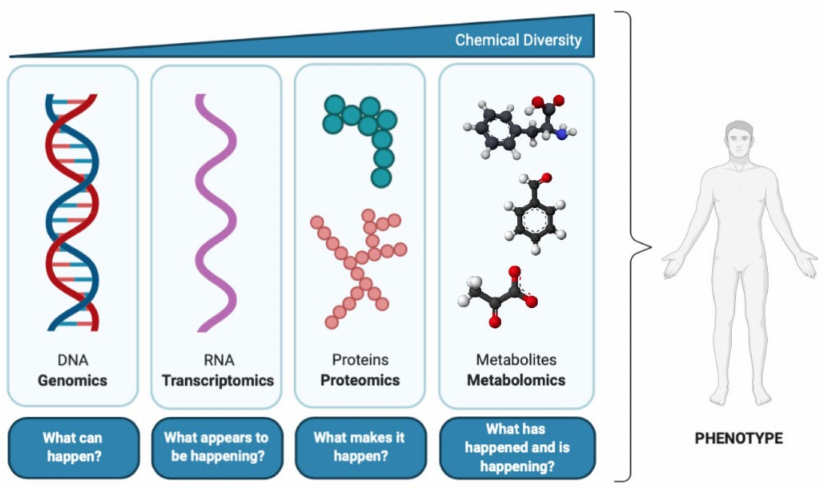
Figure 1. The central dogma of molecular biology and correspondence with ‘omics’ disciplines (adapted from